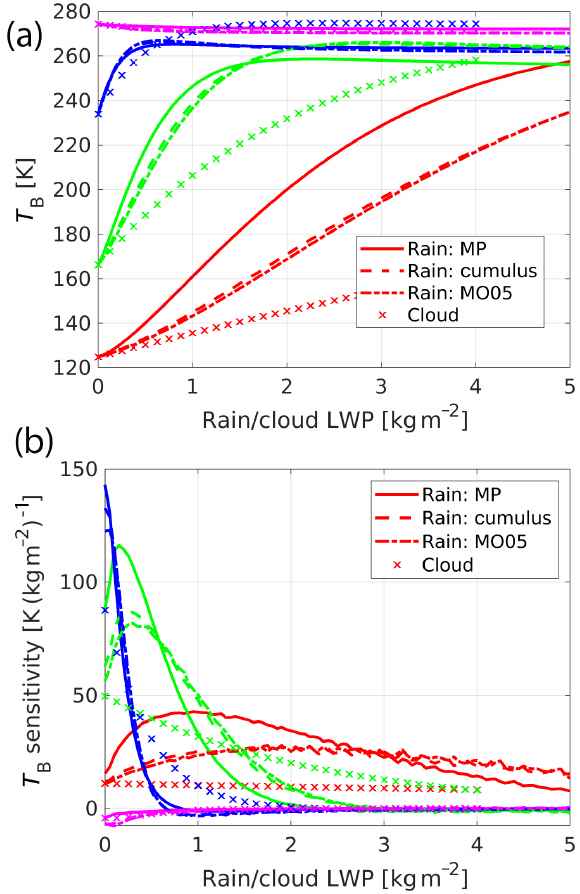
Figure 11. T B (a) and T B sensitivity (b) as a function of the c-LWP and r-LWP for a simple scenario with cloud-only and rain-only con- ditions. Different microphysics schemes are considered for rain (see text for details). Red, green, blue and magenta lines correspond to 13.6, 36.5, 94 and 220GHz,